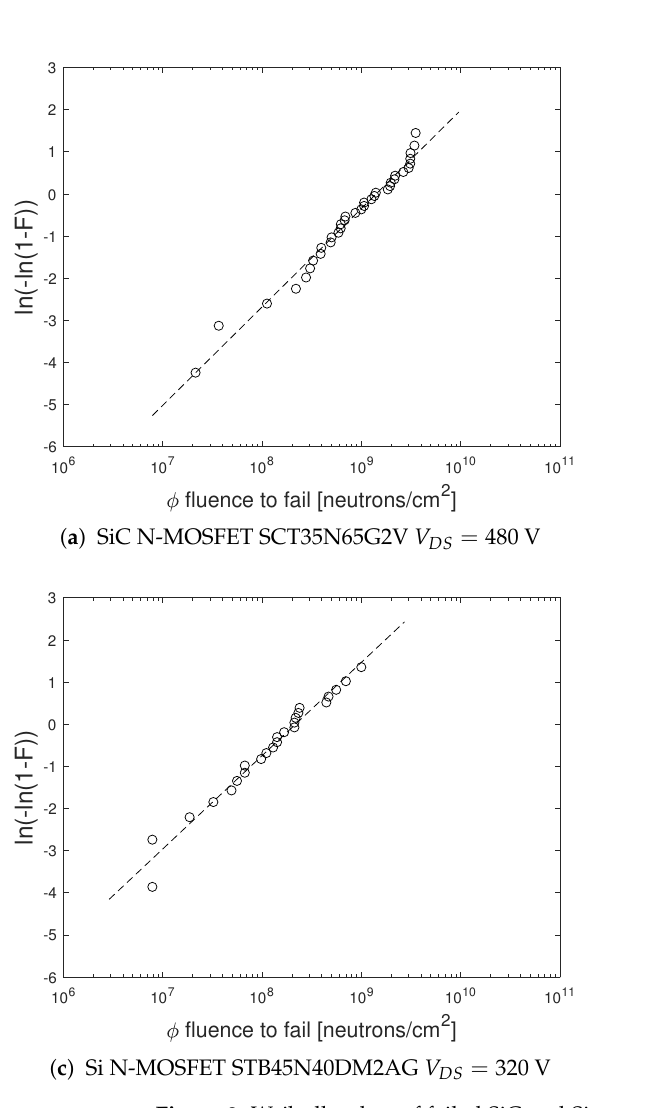
Figure 2. Weibull − plots of failed SiC and Si power MOSFETs as a function of neutron fluence. Table 3. Shape parameter ˆ β for some power devices with the lower and upper limits of the 95% confidence interval. Power